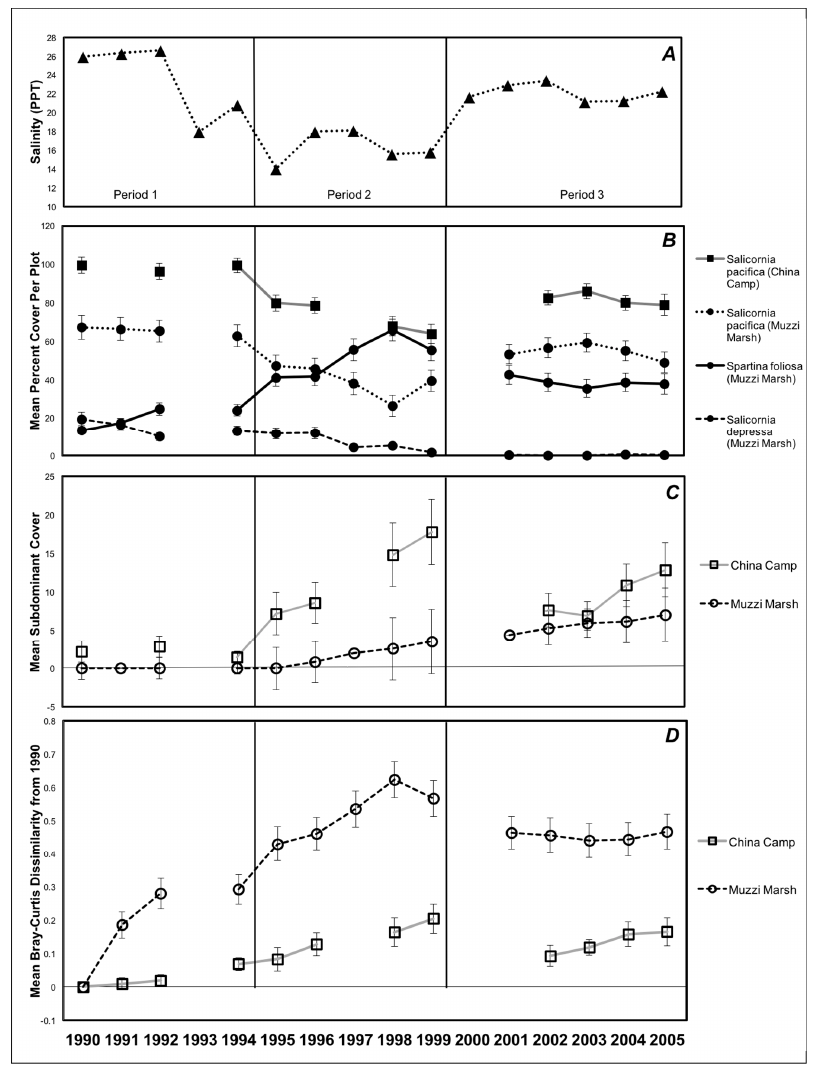
Figure 3. ( A ) Salinity from USGS Station 15. Data was collected bi-monthy for most months throughout the study period in parts per thousand (PPT); ( B ) Mean cover of pioneer/dominant species at reference and restoration sites. Throughout the study period, Salicornia pacifica was dominant at the reference site, with minimal abundance of Spartina foliosa , which is not represented here because it never comprised more than 5.3% of mean cover per plot. At the restoration site, Salicornia pacifica was dominant most years, with Spartina foliosa becoming dominant from 1997 to 1999 during the extended period of low salinity. Salicornia depressa , a salt tolerant, early colonizing annual species begins at intermediate cover in 1990 but declines to less than 1% by 2005, indicating directional change; ( C ) Mean sub-dominant cover per plot at the reference and restoration sites. Following low cover in the high salinity period 1, cover begins to significantly increase at both sites during the low salinity period 2. At the reference site, sub-dominant cover peaks in 1999, then declines overall during period 3, while cover increases incrementally every year at the restoration site; ( D ) Mean community change per plot relative to the initial community (1990) at the reference and restored sites. At both sites, change is greatest during period 2, when salinity is low. At the reference site, the change is lower overall, driven largely by the relative abundance of sub-dominant species and begins to decline following the peak of sub-dominant cover in 1999. At the restoration site, change is driven by the dynamics of the three pioneer species and sub-dominant species abundance. Change is significant over all three time periods (positive change during periods 1 and 2, negative change during period 3) but strongest during period 2. Error bars reflect the standard error of the